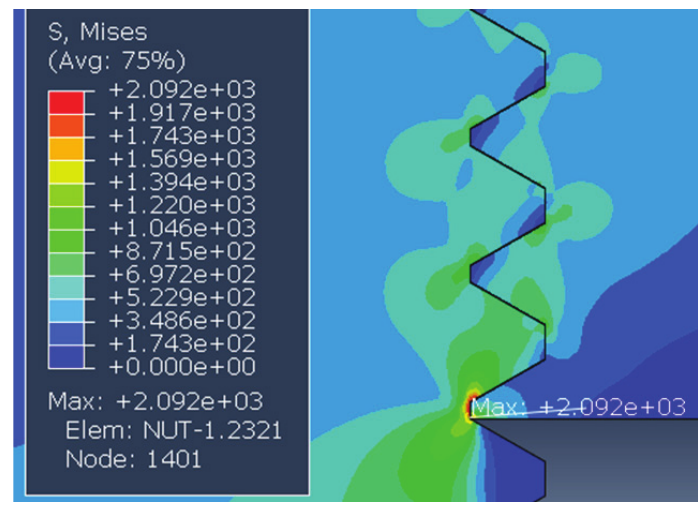
Figure 6. Stress distribution analysis using elastic properties.